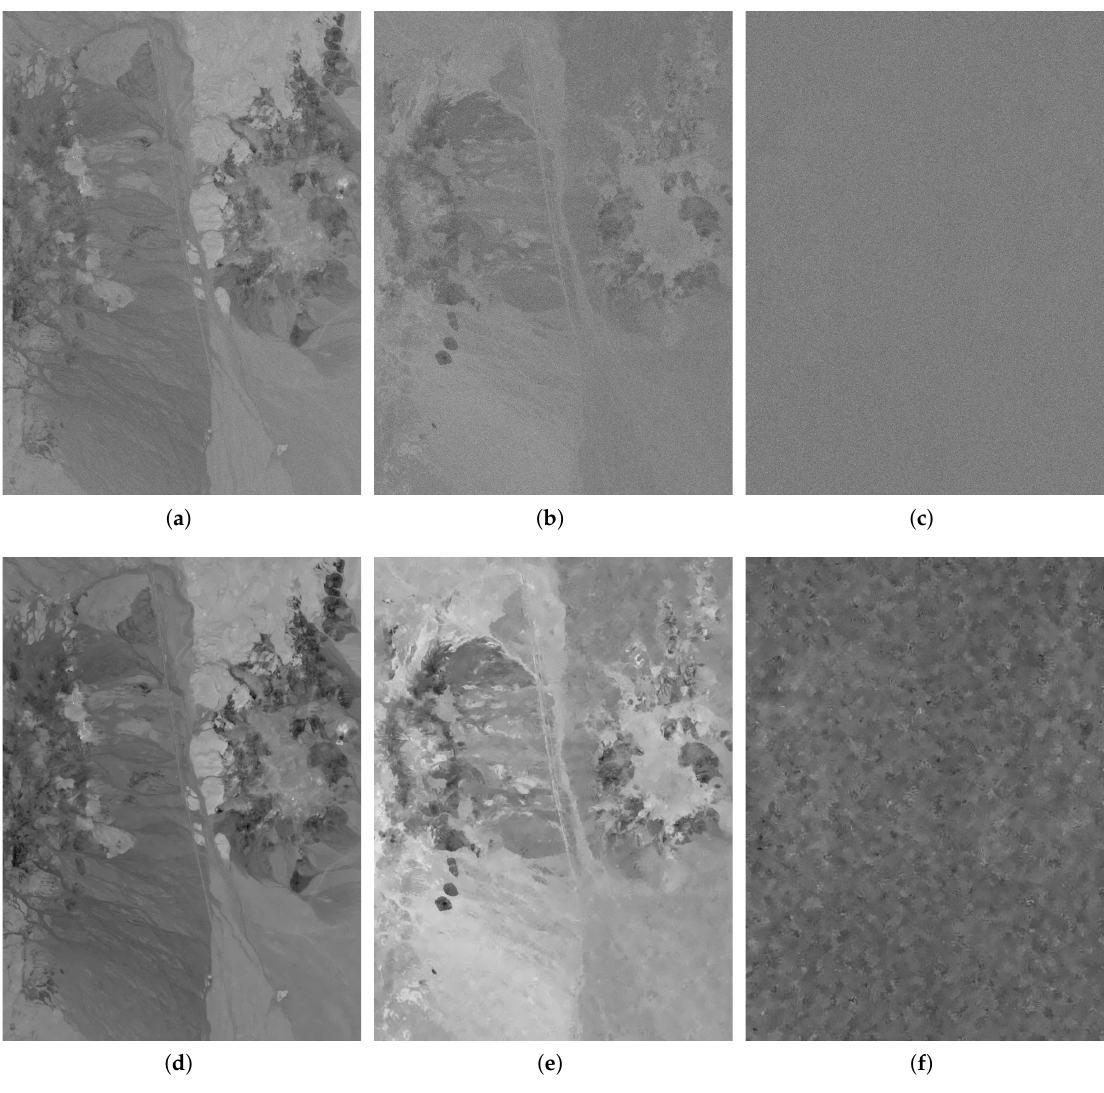
Figure 2. Eigen-images of an AVIRIS hyperspectral image at Cuprite Mining District before and after filtering: ( a ) 2nd eigen-image; ( b ) 3rd eigen-image; ( c ) 4th eigen-image; ( d ) 2nd filtered eigen-image; ( e ) 3rd filtered eigen-image; ( f ) 4th filtered